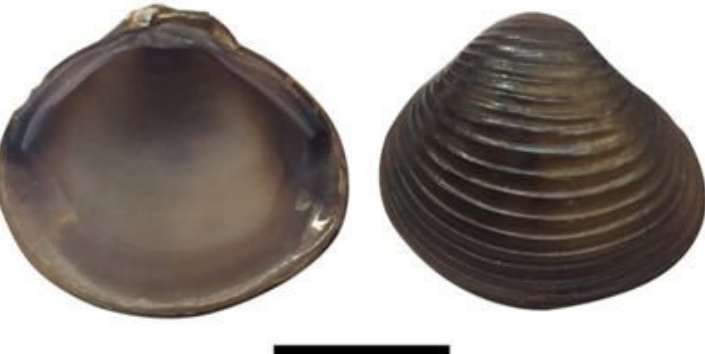
Figure 2. Internal and external views of valves of the Corbicula fluminea caught at Poxim-Açu River.